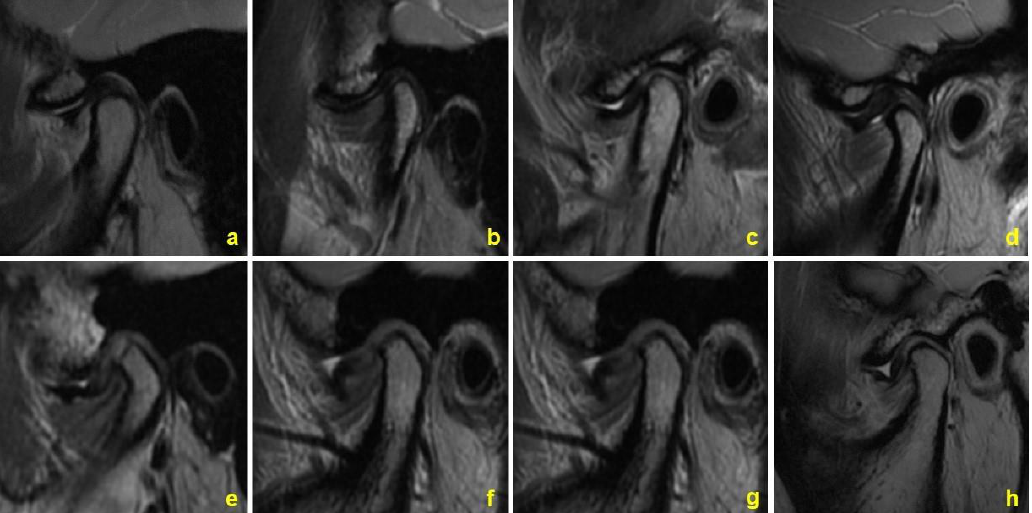
Figure 2. Huaxi classification for disc morphology. ( a ) Class 1 disc, biconcave disc with a L/W larger than 10; ( b ) Class 1 disc, biplanar disc with a L/W larger than 10; ( c ) Class 2 disc, disc bending upwards with a bending angle larger than 120 ◦ ; ( d ) Class 2 disc, disc with no bending and a L/W smaller than 10; ( e ) Class 3 disc, disc bending twice; ( f ) Class 3 disc, disc bending downwards, ( g ) Class 3 disc, disc bending upwards with a bending angle smaller than 120 ◦ ; ( h ) Class 3 disc, folded